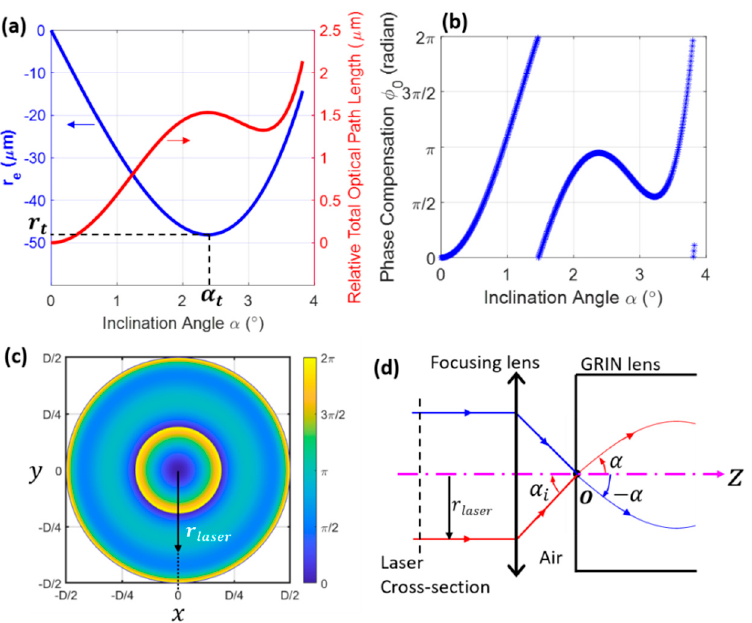
Figure 4. Simulated phase compensation. r e and relative optical path difference ( a ) and phase compensation ( b ) as a function of α . ( c ) Simulated phase compensation along the laser beam cross-section (vertical dashed line in ( d )), which is needed for obtaining the pattern shown in the bottom panel of Figure 2b. ( d ) Schematic showing the radial position of the incident laser beam, r laser , corresponding to a ray with inclination angle α . In ( c ), D is the laser beam diameter. Simulation parameters are identical to those in Figure 2.